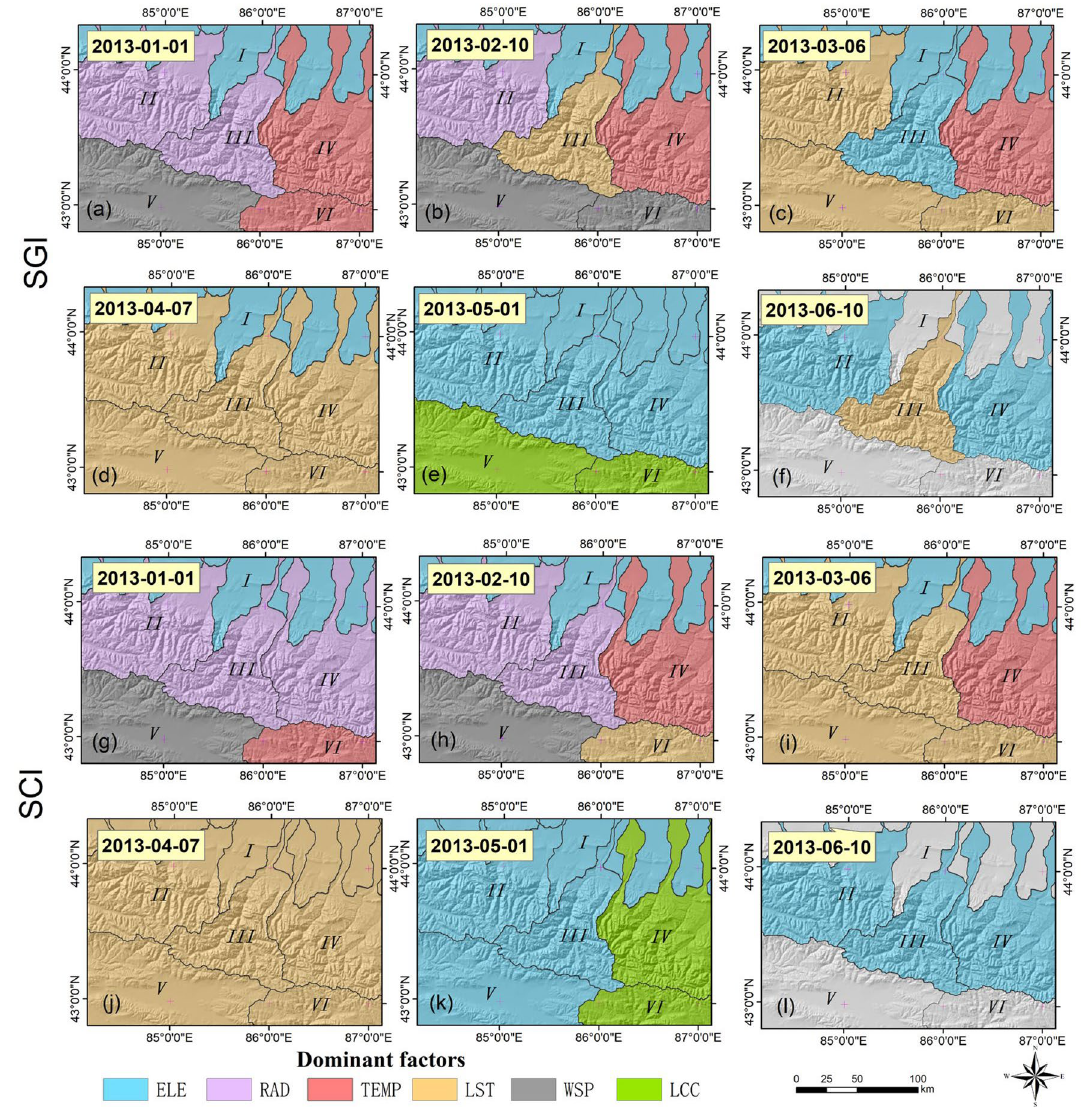
Figure 6. Spatial distribution of dominant regional factors for SGI and SCI in 2013. I–VI represent the subregions extracted after combining watershed terrain features based on the digital elevation model. Map created in ArcMap 10.6 of the Environmental System Resource Institute, Inc. (https:// www. esri. com/ softw are/ arcgis/ arcgis- for- deskt Interactions of impact factors in snow melting.